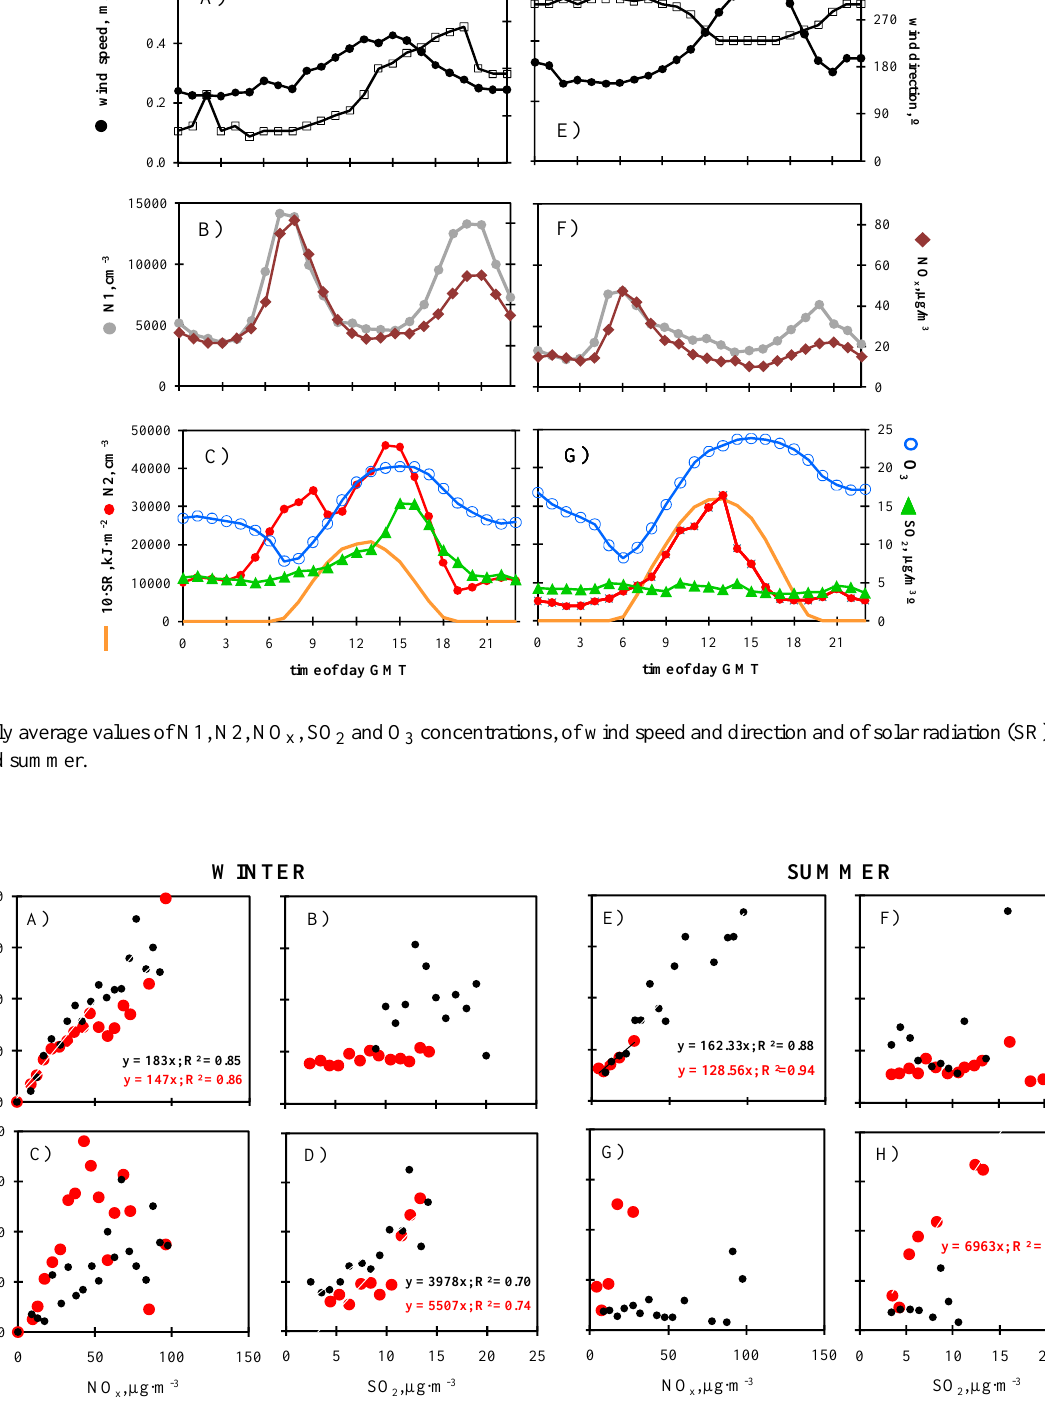
Fig. 9. Concentrations of N1 and N2 particles versus NO x and SO 2 during the morning (black circles) and noon-afternoon (red circles) in winter and summer. Data are averaged in 25µgNO x /m 3 interval widths (0–25, 25–50,...) and every 1µgSO 2 /m 3 interval width (0–1, 1–2,